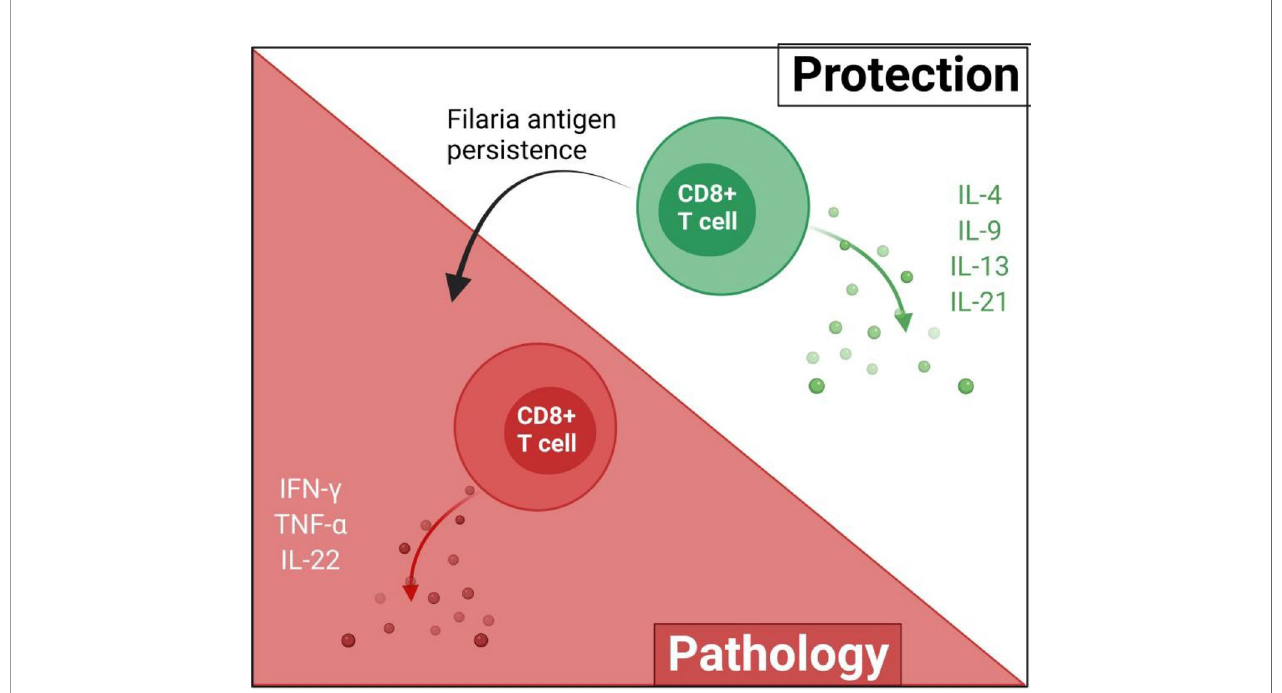
FIGURE 3 | The possible roles of CD8 + in fi larial immunity. The protective effects of CD8 + T cells are mediated by type-2 cytokines and upon the persistence of the fi laria antigens, switch to pro-in fl ammatory type-1 responses which ultimately contribute to fi larial